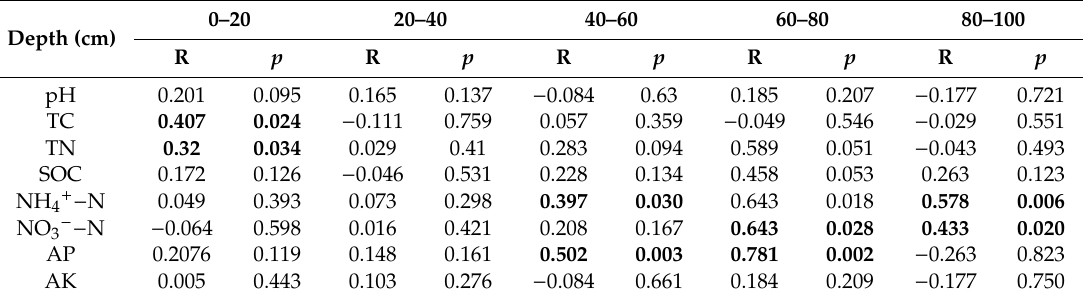
Table 3. Mantel test results for the correlation between community composition and environmental variables for bacteria across pavements. TC, total carbon; TN, total nitrogen. Bold numbers mean p <